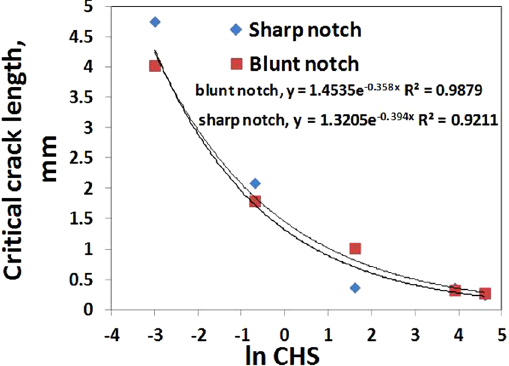
Figure 9. Plot of critical crack length of blunt notch and sharp crack specimens as a function of ln CHS at 25 °C